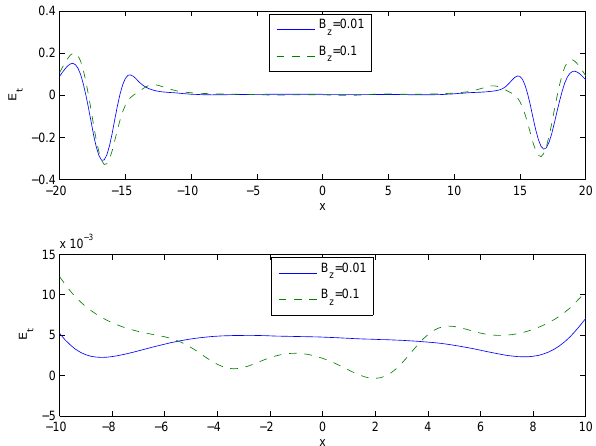
Fig. 8. The total energy density integrated in the z-direction is plot- ted as function of x at t = 20 in the upper panel. The solid line corresponds to B z = 0 . 01 and the dashed line to B z = 0 . 1. The fluc- tuations of energetic importance are located at x = ± 18 and cor- respond to a simple sound wave. The MHD eigenmodes situated between x =± 10 contain relatively little